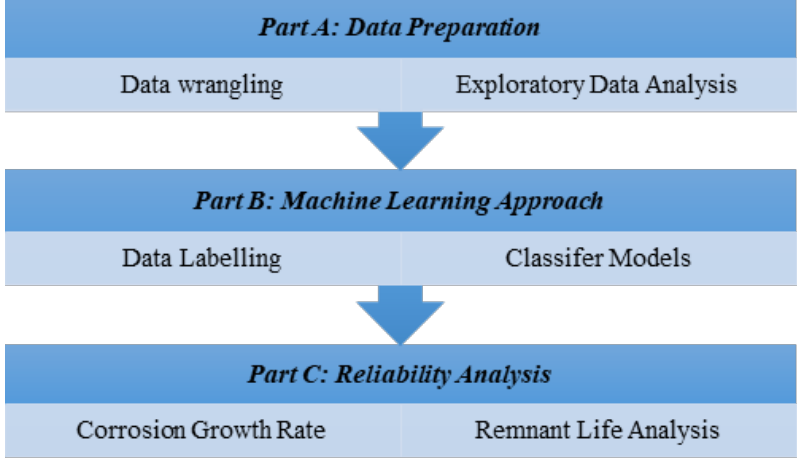
Figure 3. Process flow of the methods used.